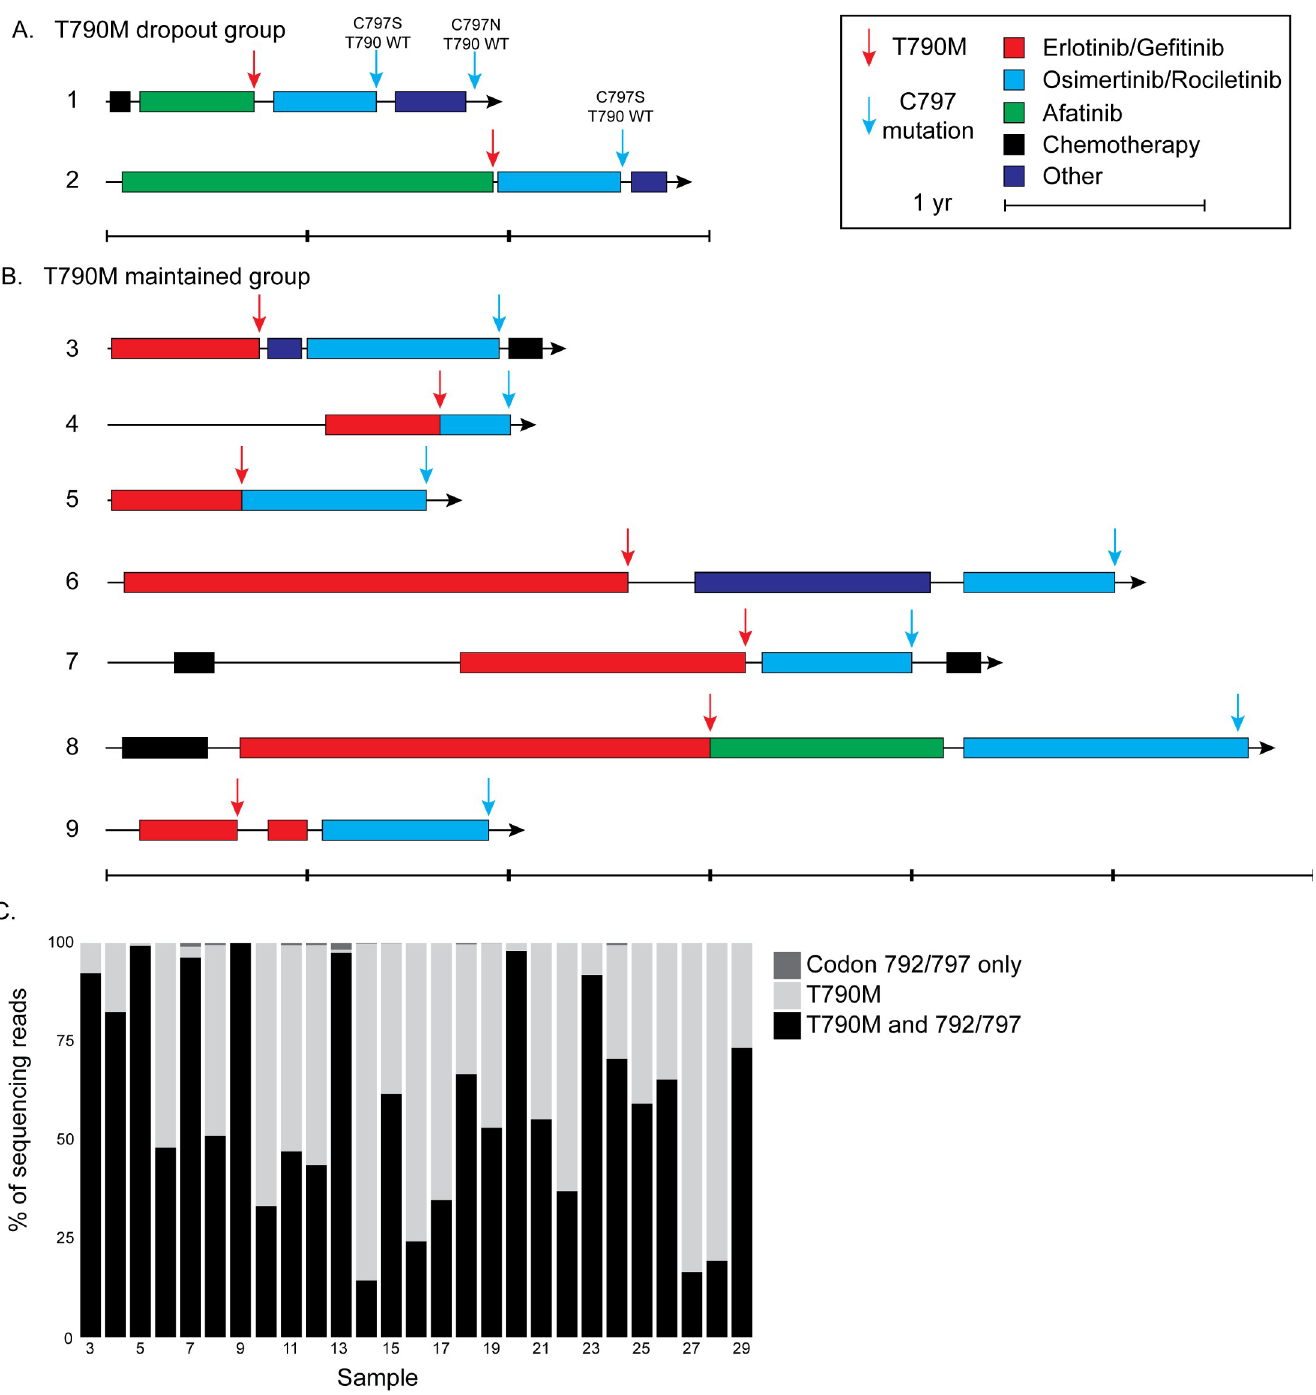
Fig 1. Treatment history and cis-trans analysis of NSCLC with co-mutations in EGFR at T790M and codon 792 or 797. Time on therapy (filled line) plus emergence of resistance mutations (arrows) is presented for tumors (A) that had T790M loss and (B) those that retained T790M. (C) An analysis of sequencing reads spanning EGFR T790 and C797. Only reads with at least one mutation of interest were counted.